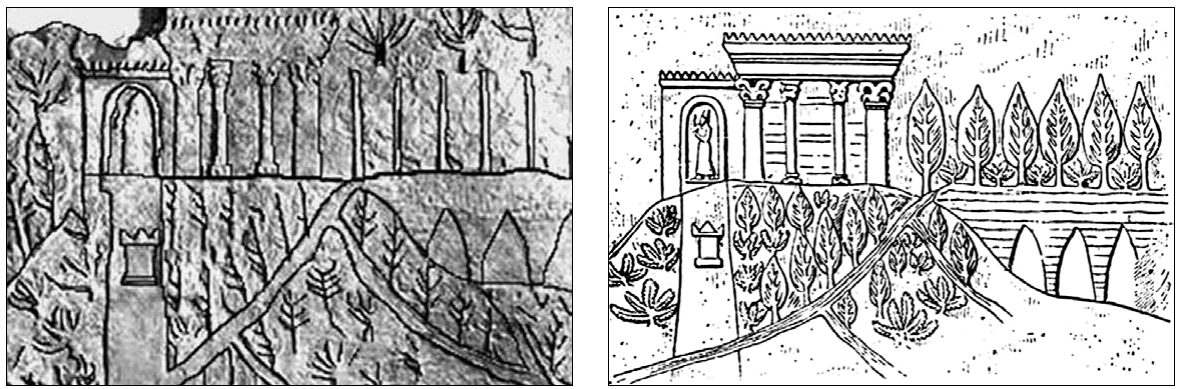
fig. 5. Bas-relief from king ashurbanipal’s palace, representing a garden irrigated by an aqueduct, Image courtesy oxford university Press 2013. Source : modified from http://www.megalithic.co.uk/modules.php?op=modload&name=a312&file=index& do